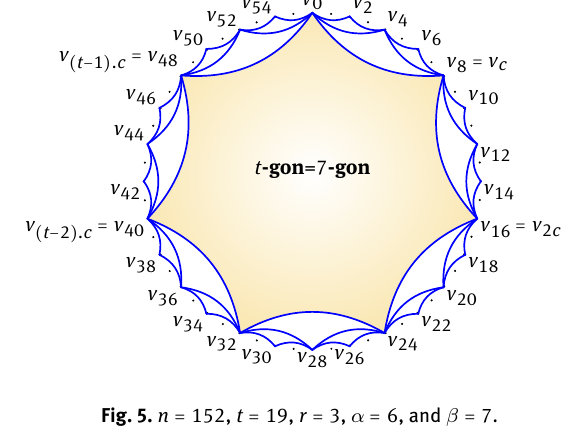
Fig. 2. n = 8 = 2 3 , t = 1 , r = r ′ − 1 = 2 , T 8 = { v j v ( j + 1 ) , j = 0, . . . ,7 } ∪ { v 2 j v 2 ( j + 1 ) , j = 0, . . . ,3 } ∪ { v 4 j v 4 = 0,1 } . ( j + 1 ) , j